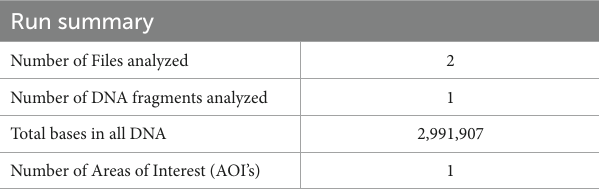
TABLE 2 Run summary for the analysis.